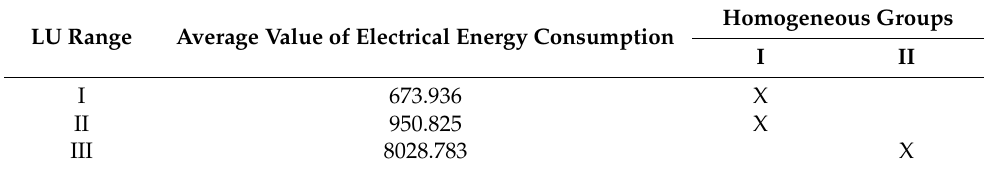
Table 9. Average values of electrical energy consumption divided into homogeneous groups ac- cording to LU range.